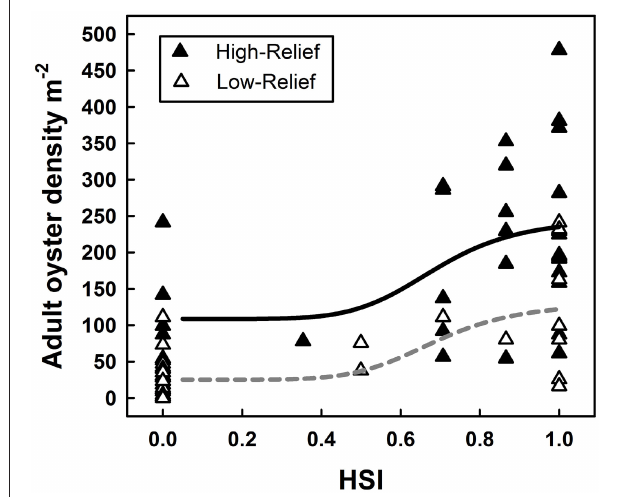
FIGURE 5 | Sigmoid relationship between habitat suitability index score and associated live adult oyster density on HRR and LRR. The solid line represents the relationship for HRR and the dashed line represents the relationship for LRR.